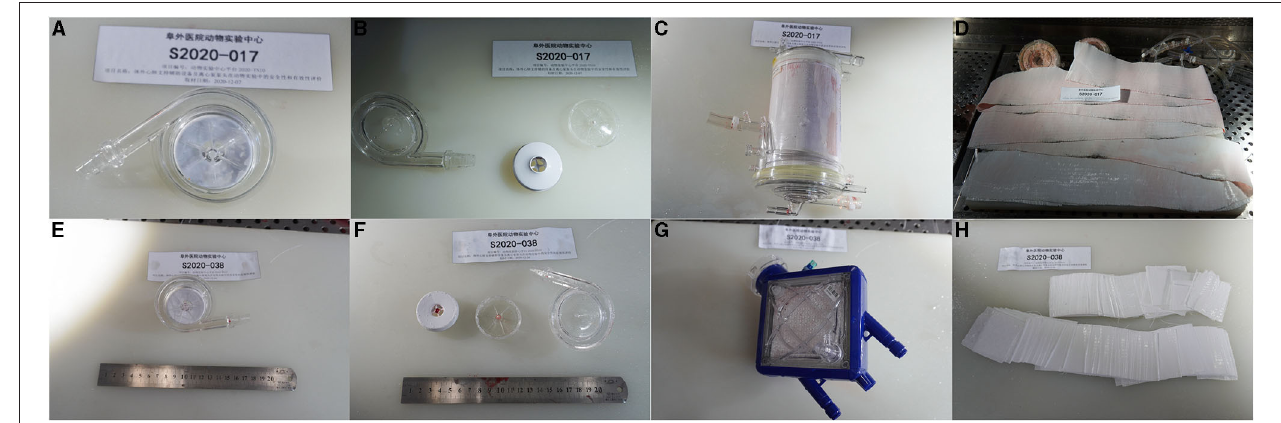
FIGURE 5 | The representative picture of the pump head and oxygenator after 7-day ECMO. (A) A representative pump head that developed no obvious thrombus in the V-V group. (B) The dissection inspection of (A) . (C) The oxygenator that formed no obvious thrombus in the V-V group. (D) The membrane inside (C) . (E) A representative pump head that developed small thrombus in the bearing pedestal in the V-A group. (F) The dissection inspection of (E) . (G) The oxygenator that formed no obvious thrombus in the V-A group. (H) The membrane inside (G) .